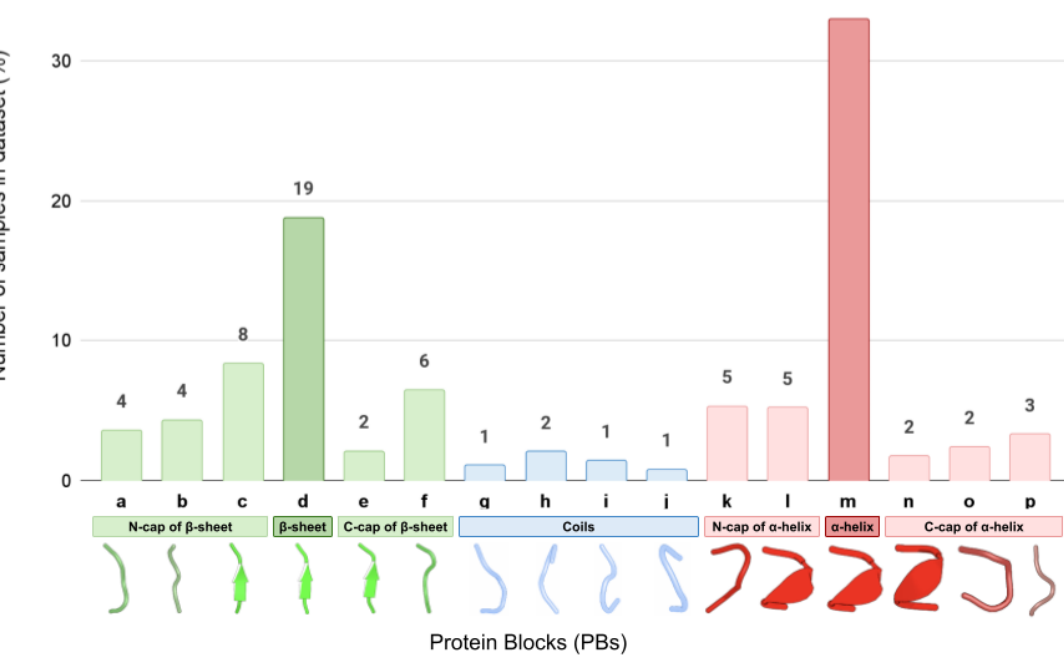
Figure 1. Number of samples (%) of each PB class in the full dataset. In order to account for the observed imbalance of different PB types, we trained two different models for PYTHIA predictions: one focused on maximizing the global accuracy of model predictions (global accuracy model) and one particularly efficient for the rare PB prediction (balanced accuracy model). The PYTHIA prediction results were then com- pared to LOCUSTRA methods in a ten-fold cross-validation as described in the Materials and Methods section Model performance evaluation. Both models outperform LOCUSTRA on average metrics. We improved the values of the MCC score by more than 10% for the global accuracy model (Table 1) and by more than 4% for the balanced accuracy model (Table 2). The global accuracy model provides the best average prediction performance compared to LOCUSTRA and performs espe- cially well for the common PB classes such as ‘m’ (centra α-helix) and ‘d’ (central β-sheet). The balanced accuracy model was trained with weights anti-proportional to the PB class sizes and therefore allows us to obtain a more equilibrated distribution of performances among all PB classes. As a result, we obtain slightly lower accuracy in the prediction of overrepresented ‘m’ and ‘d’ PBs, while boosting the performance for the PBs correspond- ing to turns, helices, and sheet C-caps and N-caps. For instance, as compared to LO- CUSTRA, we improve the true positive rate of prediction of class ‘j’ by 53% in the balanced accuracy model.